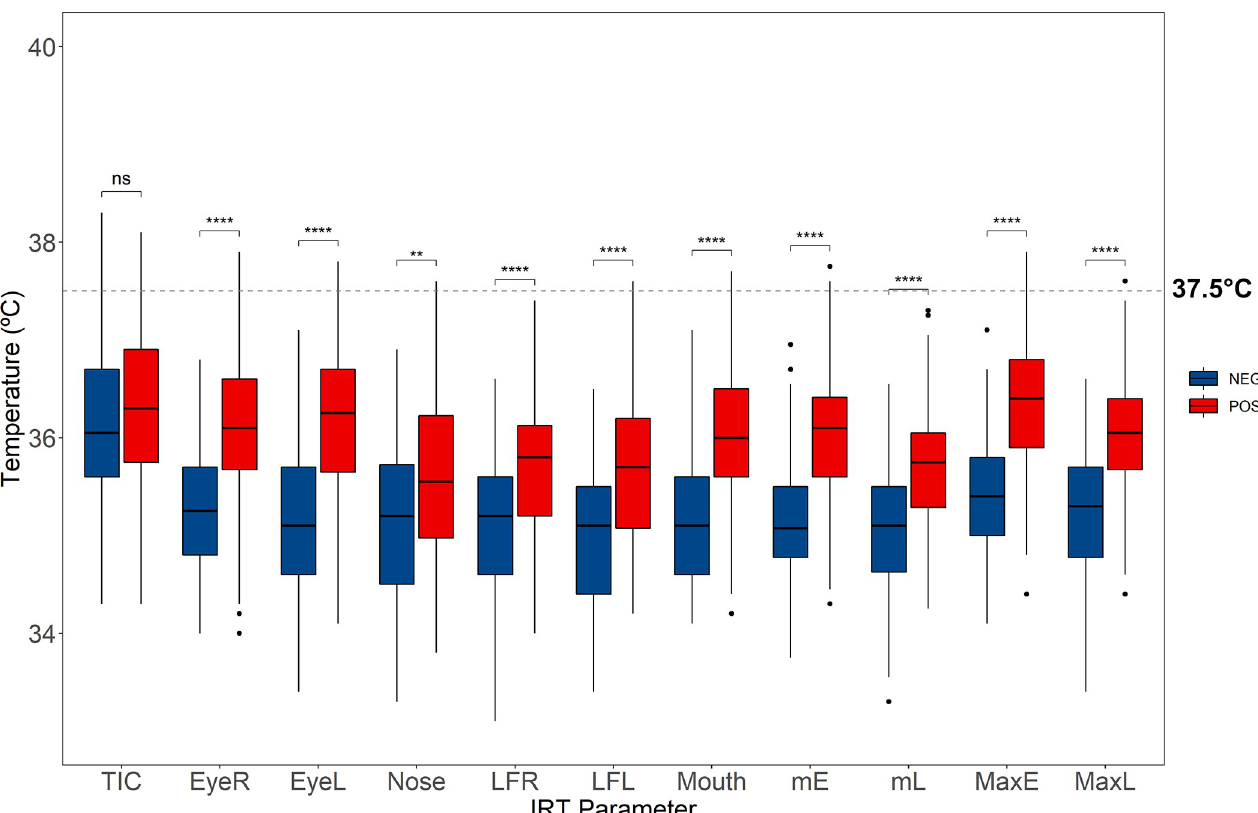
Fig 3. Boxplots of the IRT parameters between PCR+ and PCR-. The means were significantly higher for all IRT parameters, except TIC and Nose (see Table 2 for t-test results). Infected patients presented an overall higher face temperature then non-infected, however rarely within fever state (dashed line represents the temperature of 37.5˚C). ���� p < 0.0001; ns–no statistical significance.